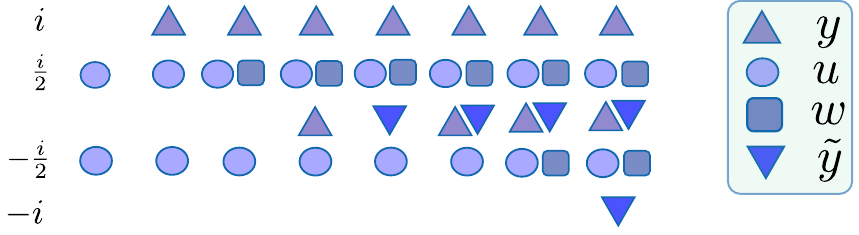
Figure 15 . The bound state module a = 2 counts 8 strings. Each string is made out of roots of type y; u; w; ~ y , represented as upper triangle, circle, square and lower triangle, respectively. The roots are placed between i and (cid:0) i in the Bethe rapidity plane. The generalization to the higher bound states is easily